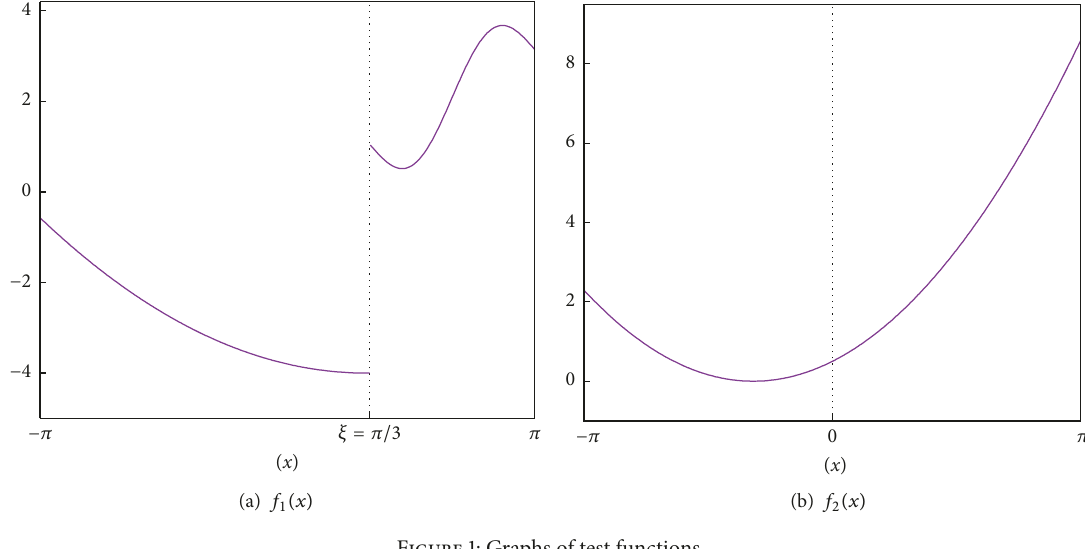
Figure 1: Graphs of test